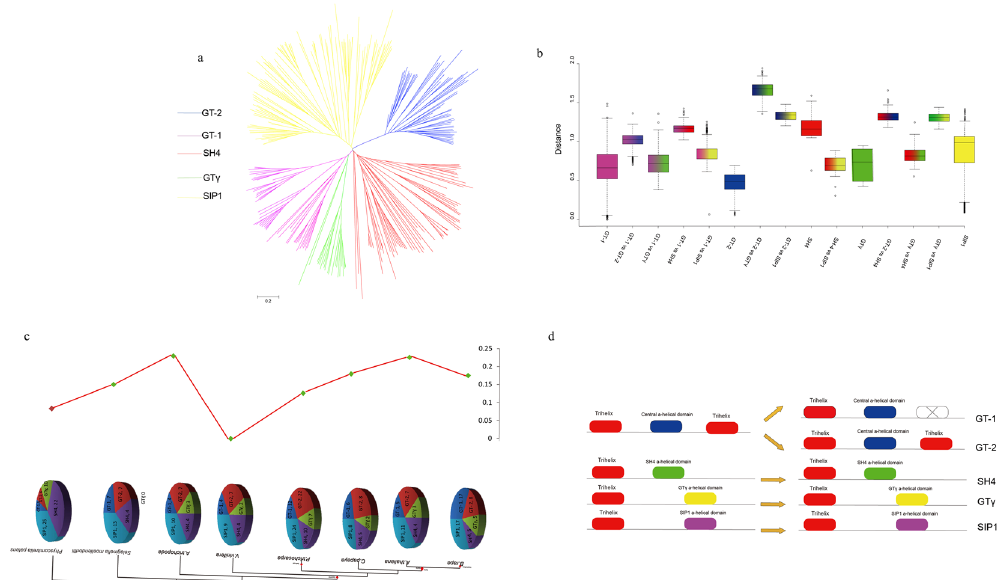
Figure 5. The analysis of trihelix genes evolution ( a )Phylogenetic relationships among trihelix genes; ( b ) genetic distance among the different groups of trihelix genes; ( c ) comparison of the percentage of trihelix genes and copy numbers of trihelix genes, trihelix genes in representative species. ( d ) The rounded red box represents the trihelix domain, the rounded bule box represents the Central a-helica domain, the rounded green box represents the SH4 a-helica domain, the rounded yellow box represents the GT γ a-helica domain, the rounded purple box represents the SIP1 a-helica domain and the noncolored rounded box represents the lost